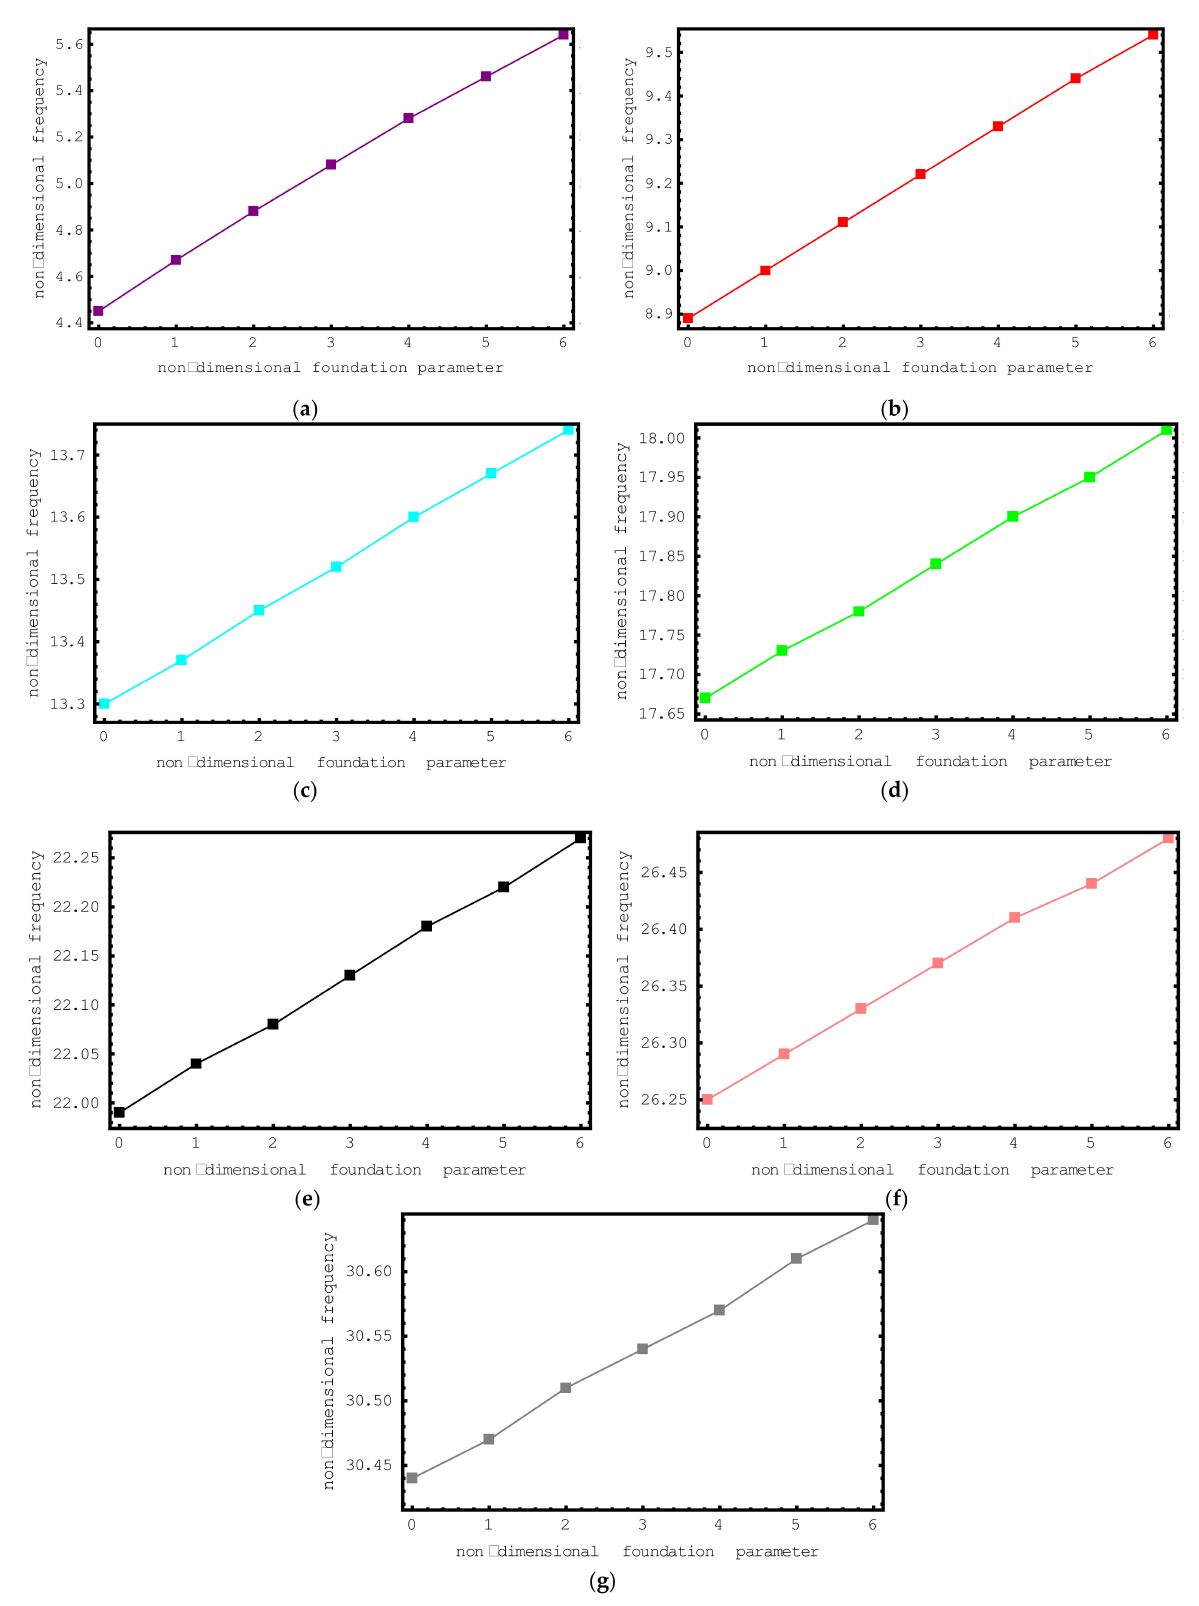
Figure 6. The variations of non-dimensional frequencies of short-fiber-reinforced composite nano- rods versus the foundation parameter: ( a ) 1st mode ( b ) 2nd mode ( c ) 3rd mode ( d ) 4th mode ( e ) 5th mode ( f ) 6th mode ( g ) 7th